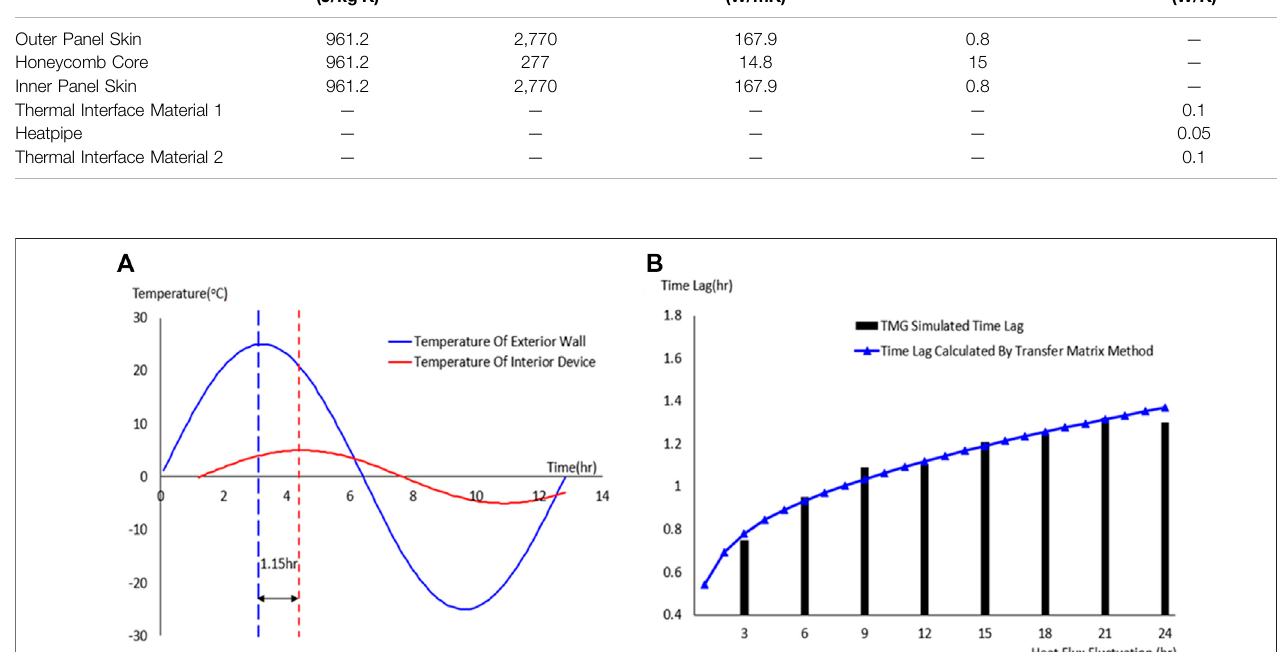
TABLE 1 | Thermal properties of different material through the heat transfer path. Thickness (mm) Thermal Resistance Speci fi c Heat Density (kg/m 3 ) Thermal Conductivity (W/mK) (W/K) (J/kg · K) Outer Panel Skin 961.2 2,770 167.9 0.8 — Honeycomb Core 961.2 277 14.8 961.2